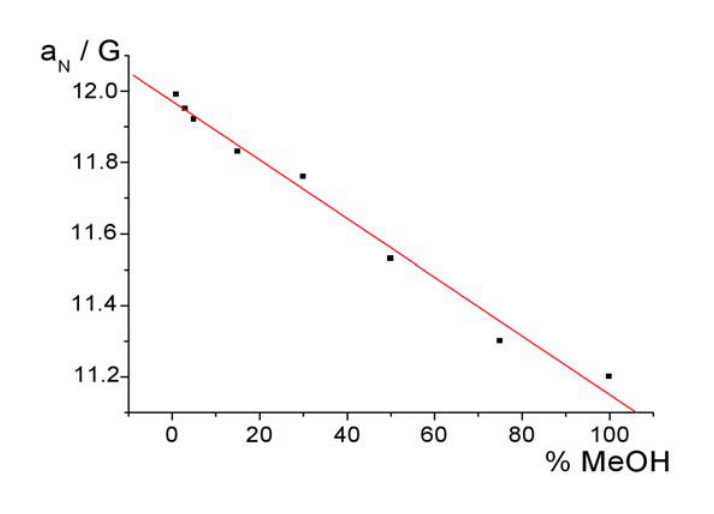
Fig. 2 Linear variation of the hyperfine coupling constant a N (in G) of the spin